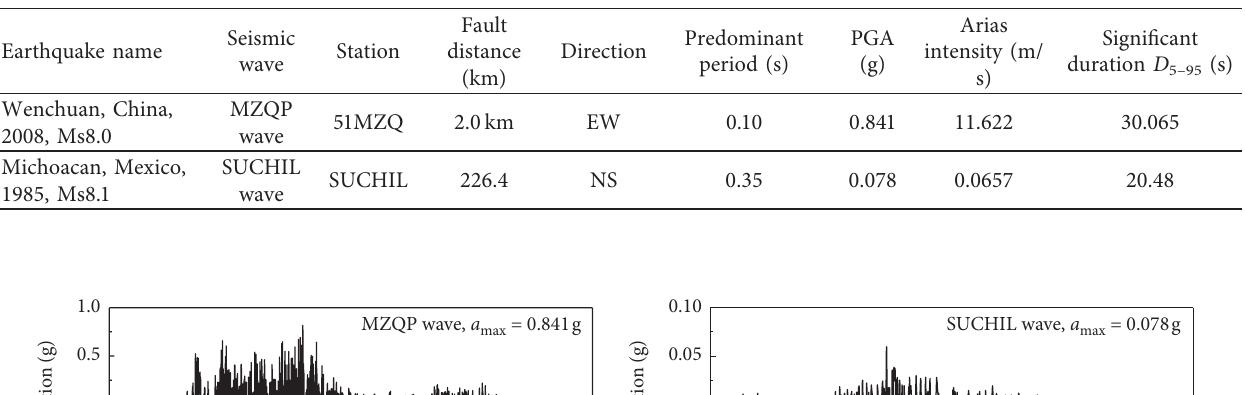
Table 5: Input bedrock ground motion information.